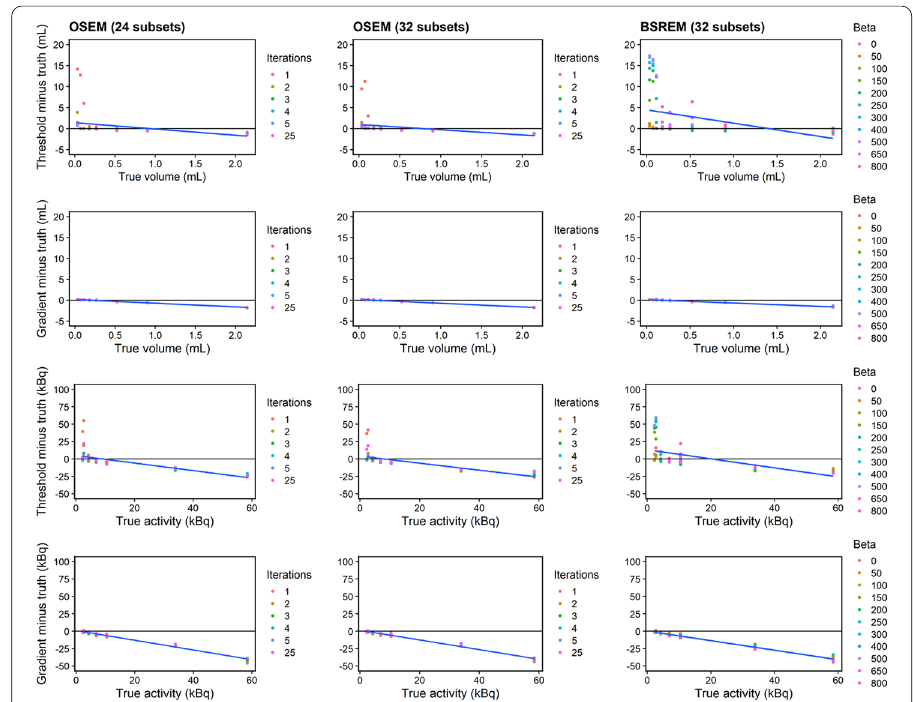
Fig. 8 Tumour volume and uptake accuracy using 40% fixed threshold and gradient segmentation. Difference between measured value and ground truth, plotted vs. ground truth, for metabolic tumour volume (MTV) and total tumour uptake (TTU) metrics. (Top to bottom) 40% FT and gradient segmentation. (Left to right) Reconstruction algorithms using OSEM PSF (24 and 32 subsets respectively) and BSREM. Blue + line indicates overall